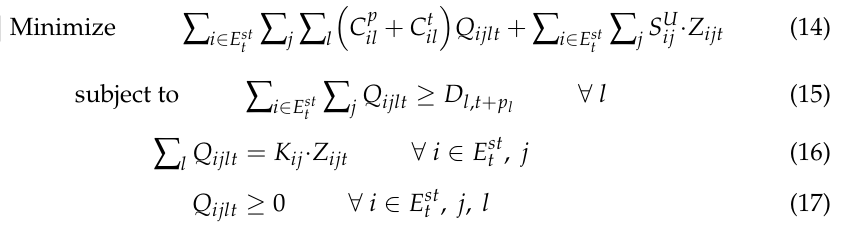
Procedure 1. (Two-step heuristic for